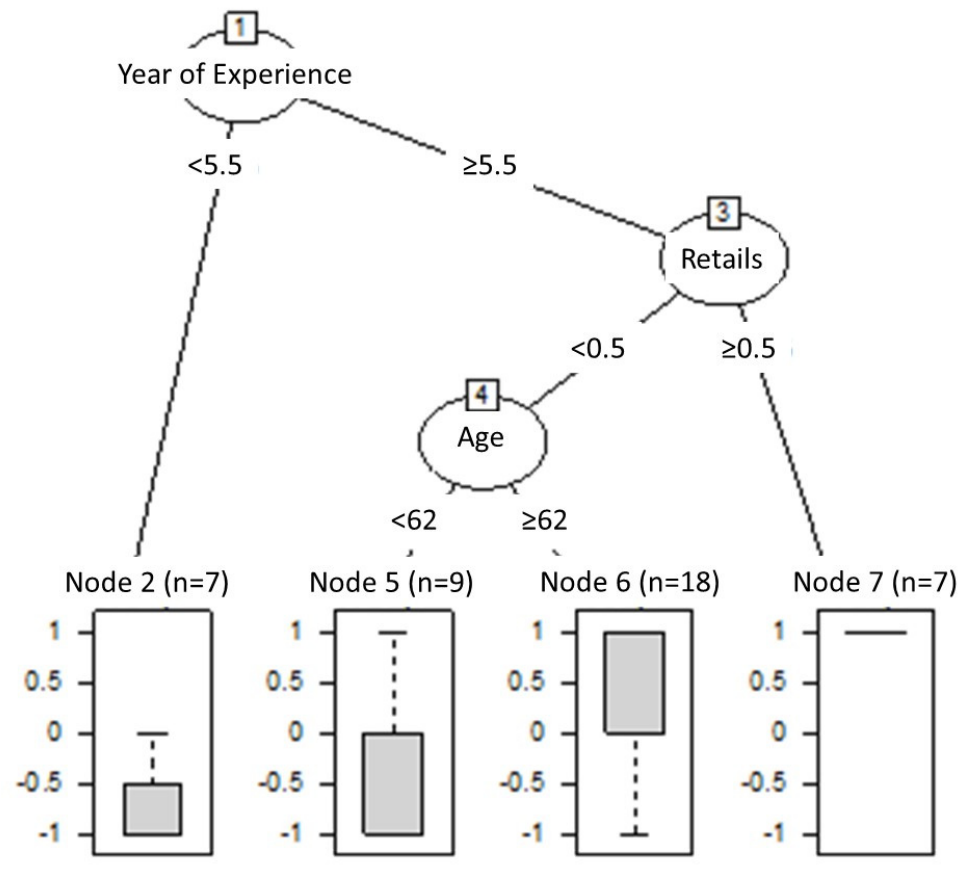
Figure 2. Regression tree of income increase among farmers practicing conservation agriculture. (Note: The nodes of years of experience, age, and retail indicate the number of years of conducting conservation agriculture, age of farmers, and trade with a retail shop where farmers sell their products, respectively.)